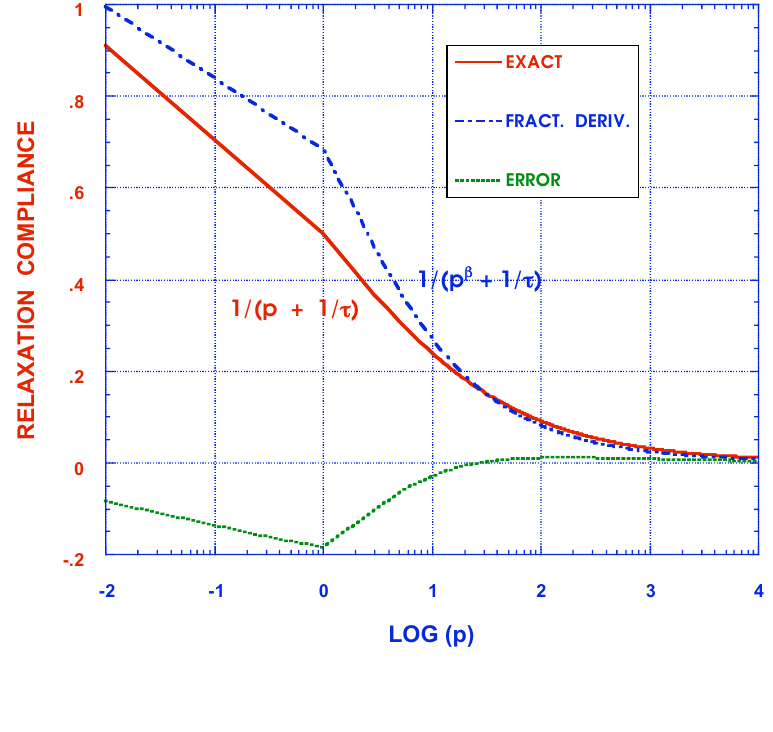
Figure 3. Comparison of exact and approximate relaxation moduli Laplace transforms of 1 / ( p β + 1 /τ ) and 1 / ( p + c ) µ